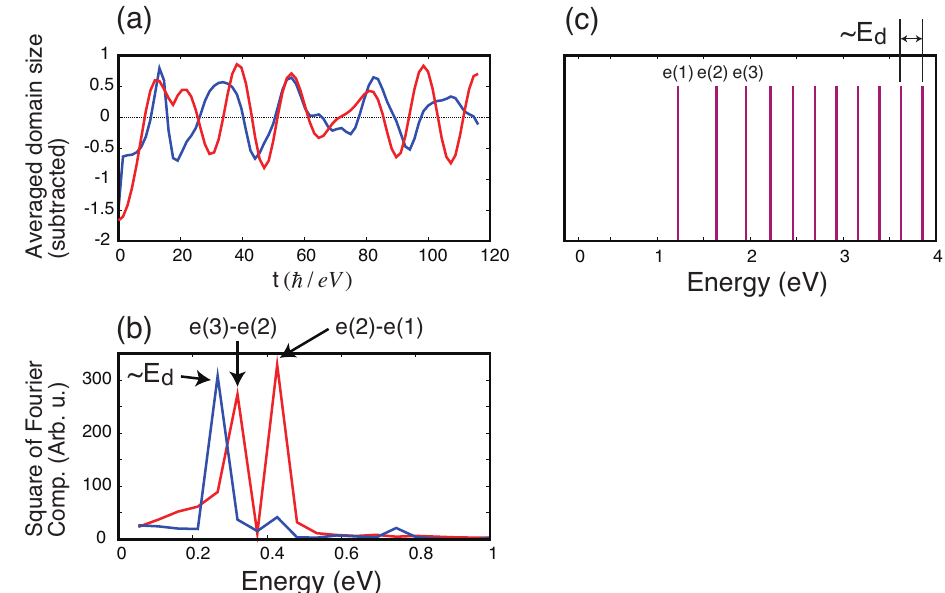
Figure 7. ( a ) Time evolutions of the averaged domain size from which the background component is subtracted. Both the curves are obtained with ∆ ef f = 0.50 eV. The red curve is the same as that in Figure 6a, namely, with ω c = 1.7 eV. The blue curve is calculated assuming ω c = 10.2 eV. ( b ) Squared magnitudes of Fourier components of each trajectory. Same colors as those in ( a ) are used for different excitation energies. ( c ) Eigenenergies measured from the ground state, for ∆ ef f = 0.50